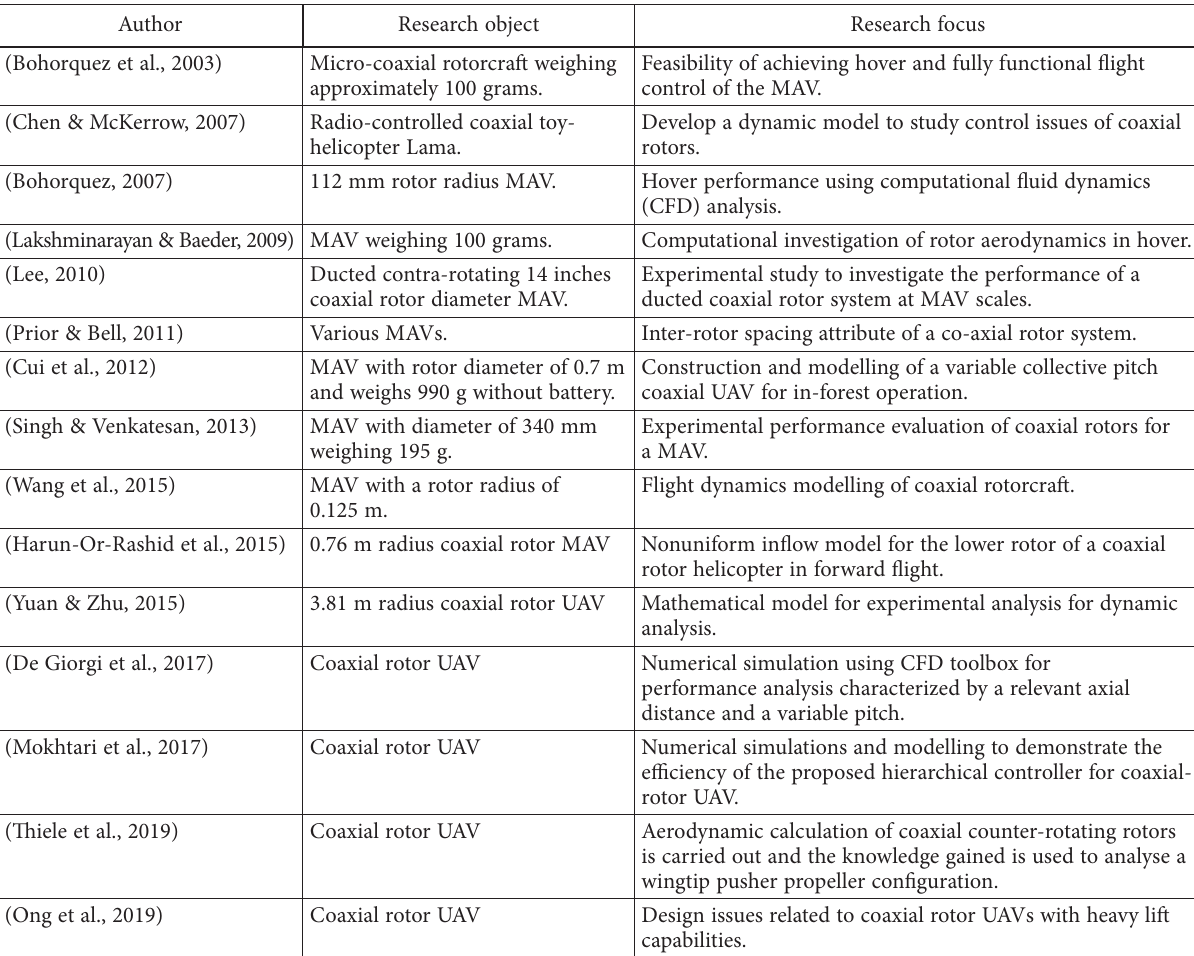
Table 1. Research on coaxial rotor